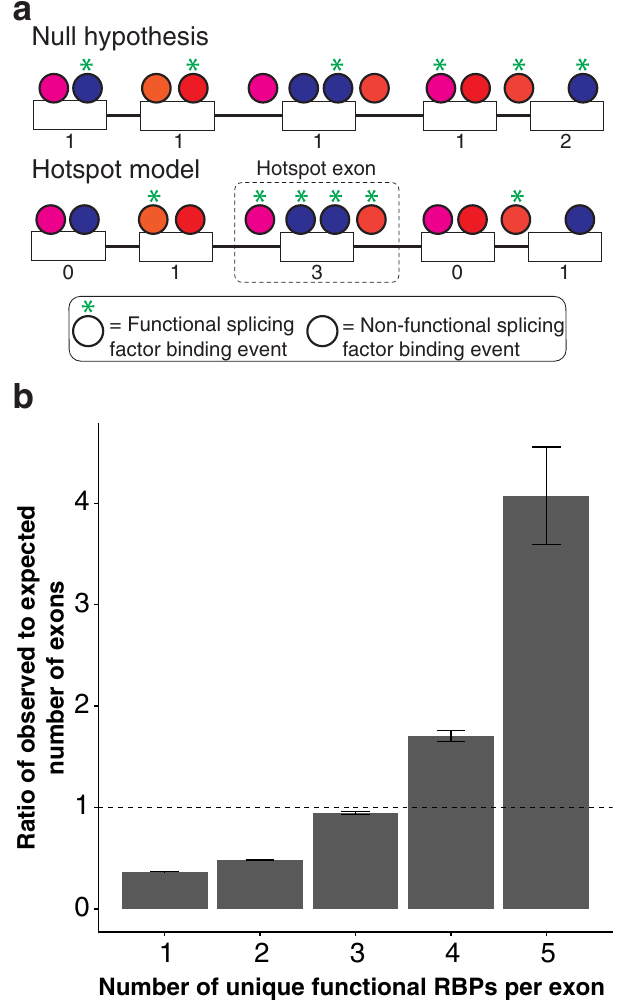
Fig. 4 Hotspot exons depend on several RBP-binding events. a Hotspot exons tend to rely on multiple RBPs for correct splicing. Numbers below exons indicate how many unique RBPs are required for the splicing of the exon. Circles of the same color represent the same RBP. b Enrichment above expectation in the number of exons with various numbers of unique RBPs necessary for splicing ( n = 3505 binding sites). Data are presented as mean ±